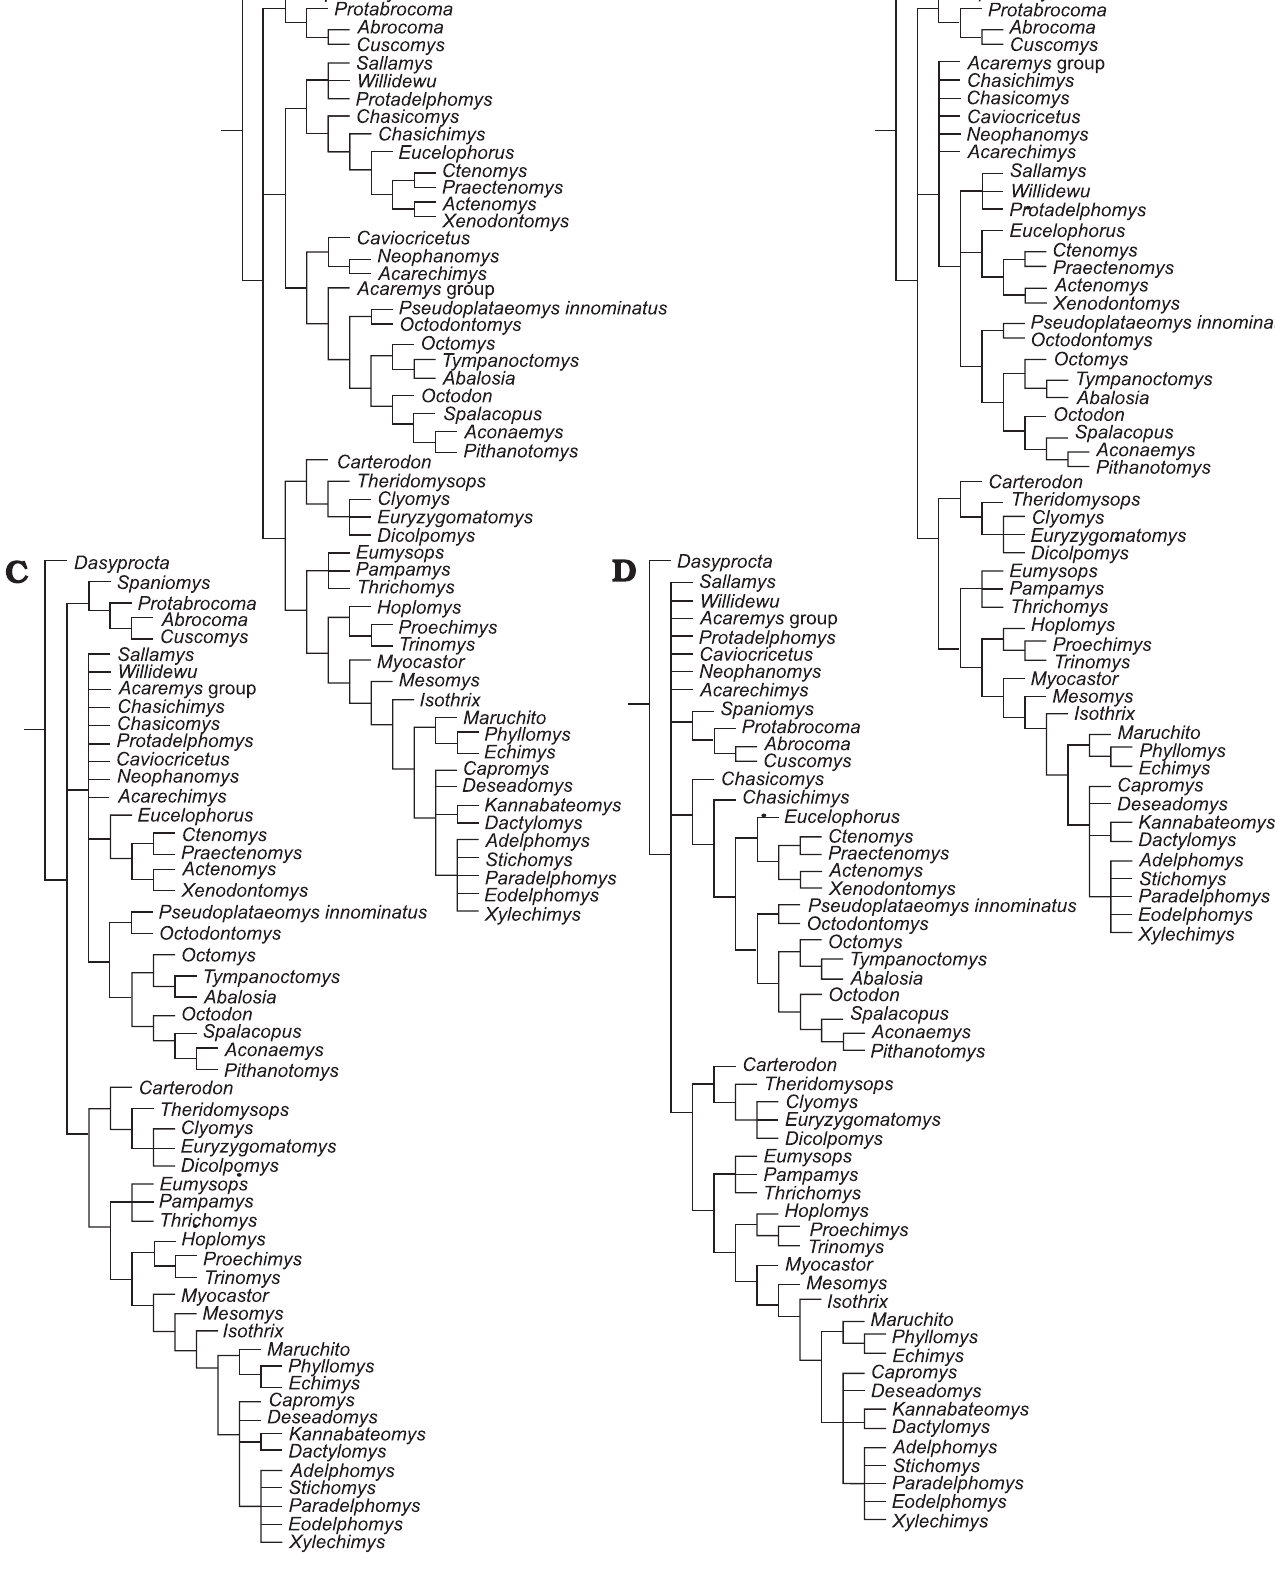
Fig. 7. A . Strict consensus trees from analysis of Verzi et al. (2014). B . Strict consensus of 27 MPTs of 139 steps resulting from the cladistic analysis